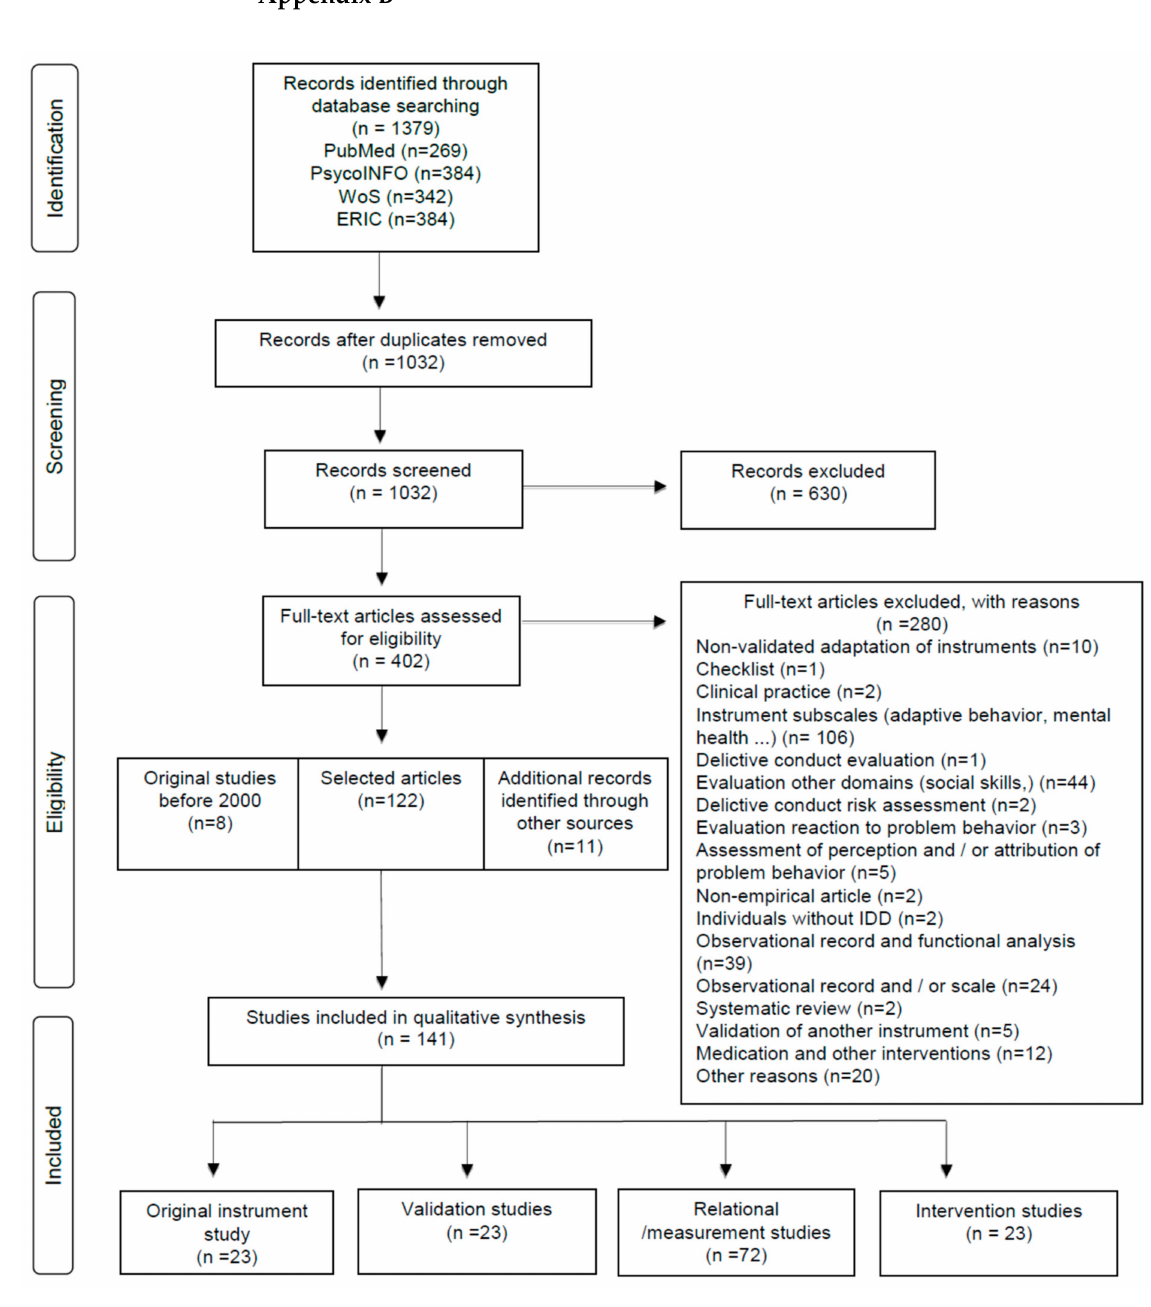
Figure A2. PRISMA Flow